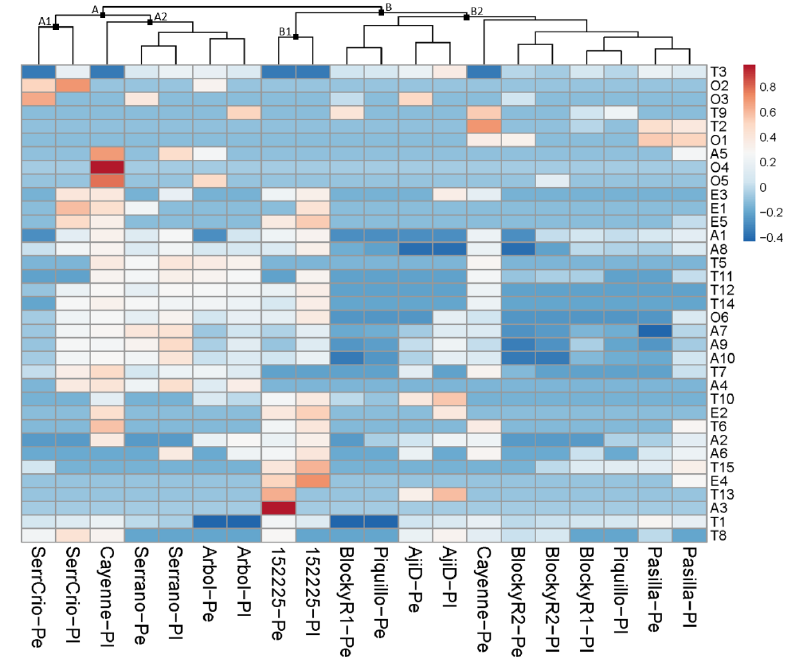
Figure 1. Heatmap hierarchical cluster analysis of the volatiles identified in the parent accessions studied, corresponding to the pericarp (Pe) and placental (Pl) tissues. Accession and volatile abbreviations correspond to those indicated in Tables 1 and 2, respectively.